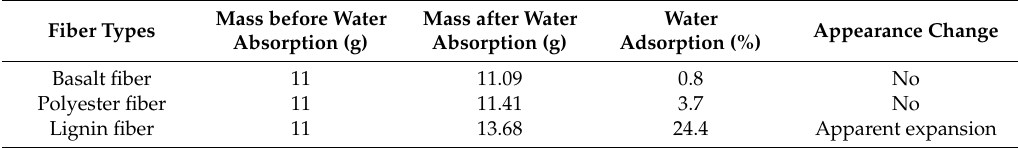
Table 7. Water absorption for three kinds of fibers.